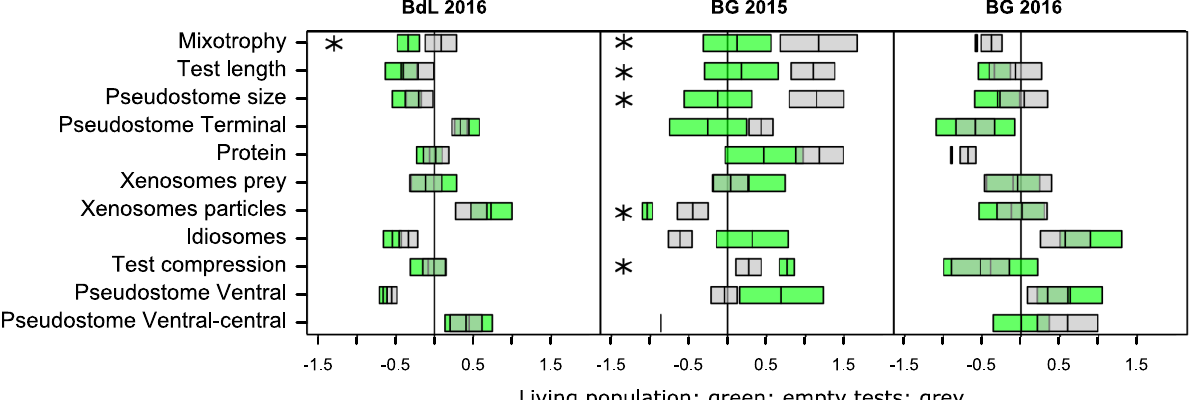
Figure 5. Boxplots of community weighted mean of traits in living and dead testate amoeba assemblages in the Neuchâtel Botanic Garden experimental peatland (BG 2015, BG 2016) and the Bois-des-Lattes reference peatland (BdL). Boxes represent standard error and vertical black lines the mean values of CWM for the sites (z-scored). Traits are arranged in order of decreasing humidity, with traits at the top expected to decrease with water stress and traits at the bottom to increase with water stress. Stars indicate significant trait differences between living and dead assemblages, based on a Wilcoxon rank test for paired value and exact p-value when